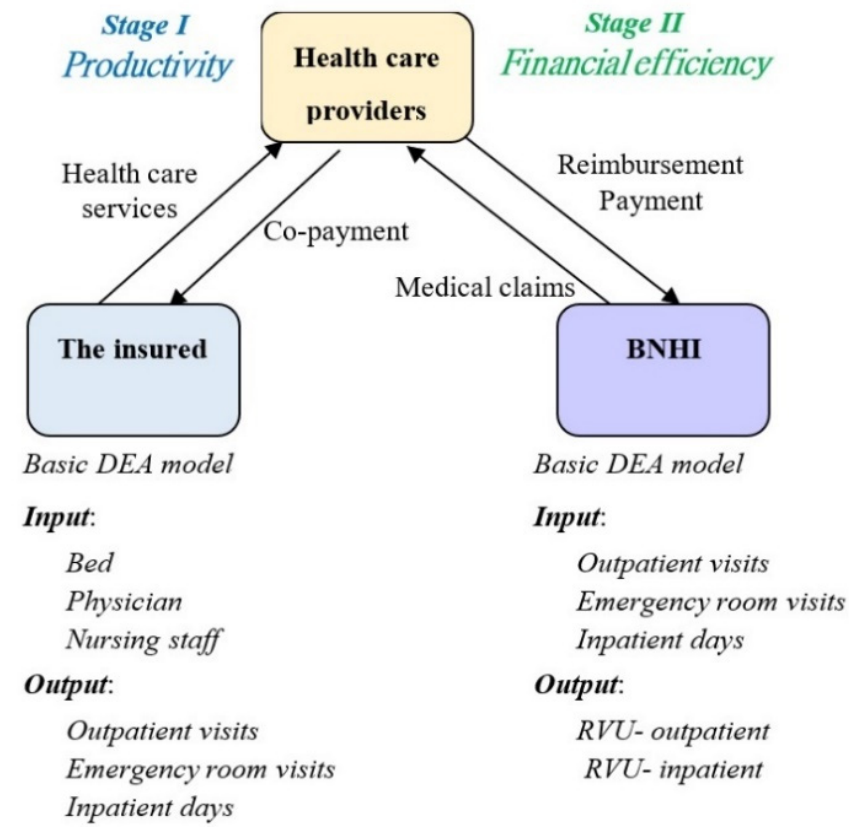
Figure 3. A two-stage DEA model to measure efficiency in Taiwan’s NHI